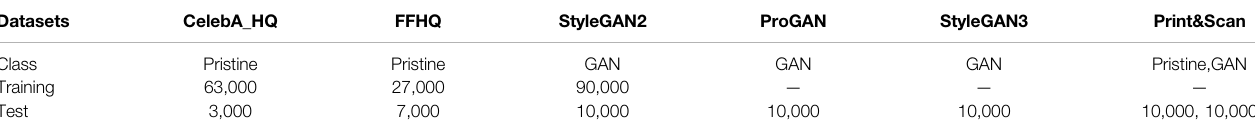
TABLE 1 | Datasets used for training and